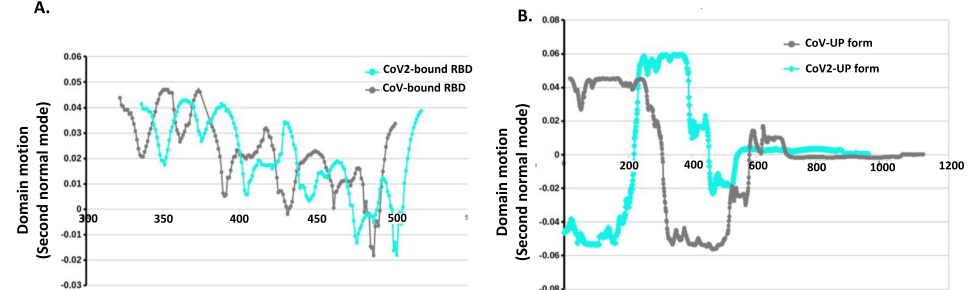
Figure 6. Domain motions in second normal mode ( A ) Residue-wise eigenvectors of bound RBD AA residues is representing low-frequency motions. There are no significant differences in bound RBD motions between both the SARS-CoV-1 complexes. ( B ) Without hACE binding, RBD up-conformation protomer is showing significant differences in the domain motion in the RBD regions. It is like anti-phase-type dynamics between the two CoVs structures. Cyan dots represent CoV-2-RBD AA residue phi-psi position, while black is for CoV-1